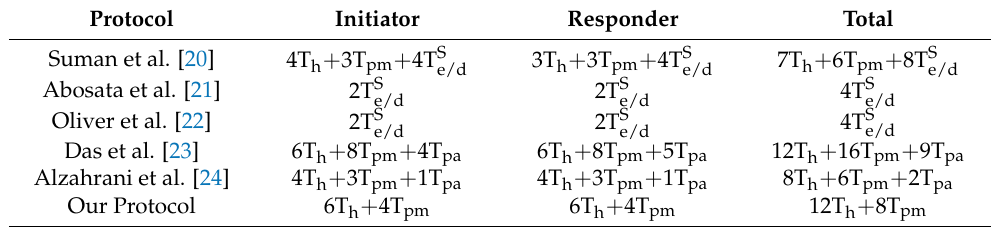
Table 6. Comparison of computation overhead with similar schemes.